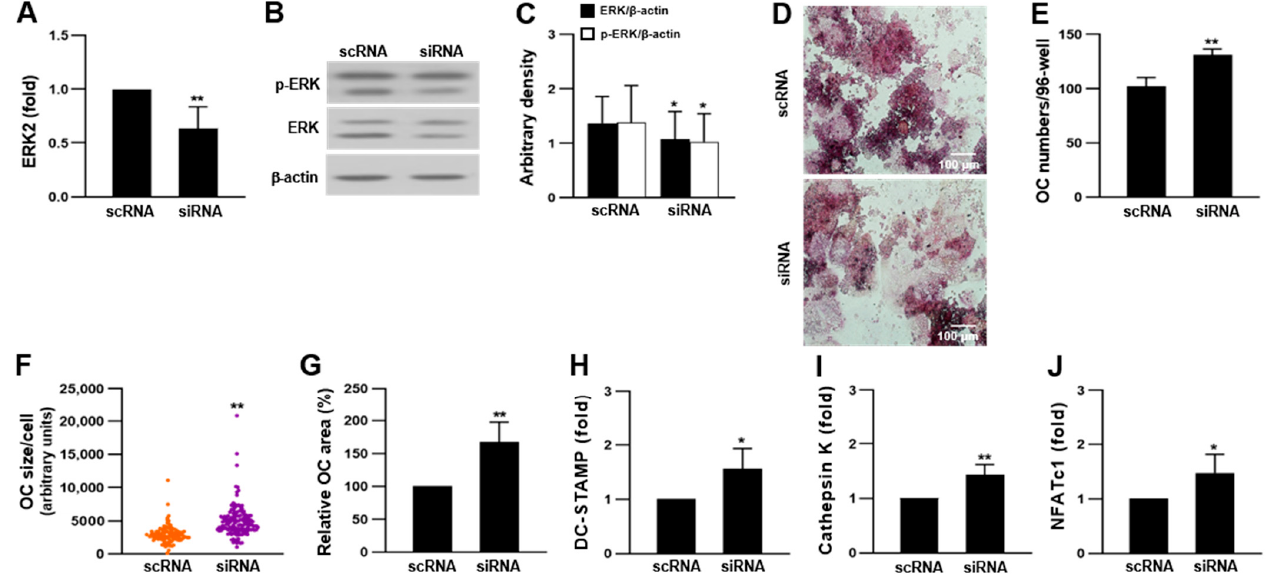
Figure 3. Downregulation of ERK with ERK2 siRNA increased OC differentiation in RAW 264.7 cells. Cells were transfected with ERK2 siRNA and differentiated into OCs in the presence of 50 ng/mL RANKL for 4 days. ( A – C ) Effect of ERK2 siRNA on the expression of ERK (n = 5 for mRNA and n = 3 for protein). ( D , E ) Effect of ERK2 siRNA on OC differentiation (n = 3 independent experiments, each performed in triplicate). ( F , G ) Relative size of OC and OC area per well of OCs of ERK2 siRNA-transfected cells (n = 3). ( H – J ) Quantitative analyses of mRNA expression of OC markers, DC-STAMP and cathepsin K, and NFATc1 was measured by qRT-PCR (n = 3). Each result represents the mean ± SD. * p < 0.05 and ** p < 0.01 vs. scRNA.